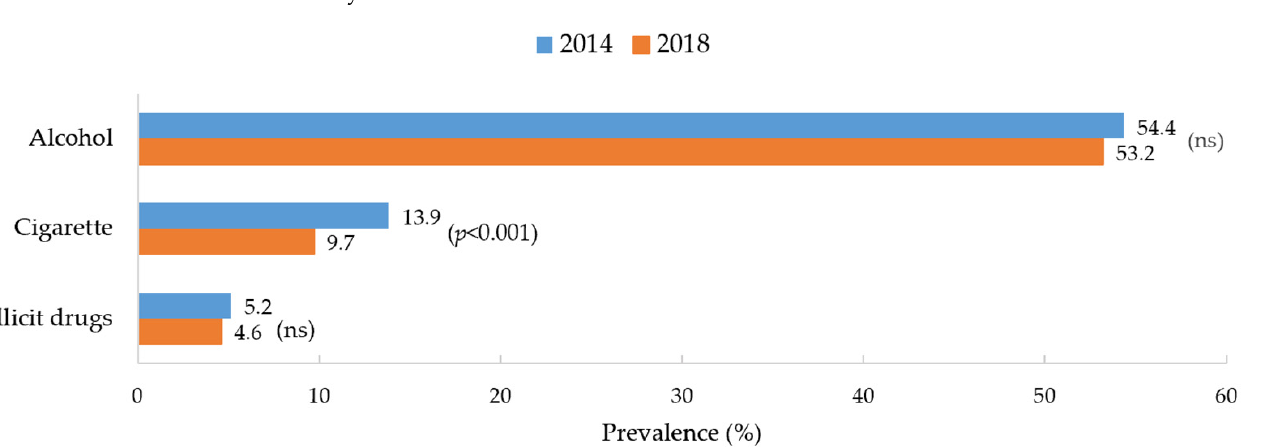
Figure 1. Changes in the rates of lifetime use of alcohol, cigarettes, and illicit drugs from 2014 to 2018. Note. Only significant p values are shown, with ‘ns’ meaning p values are not significant. The level of significance was set at p < 0.05.